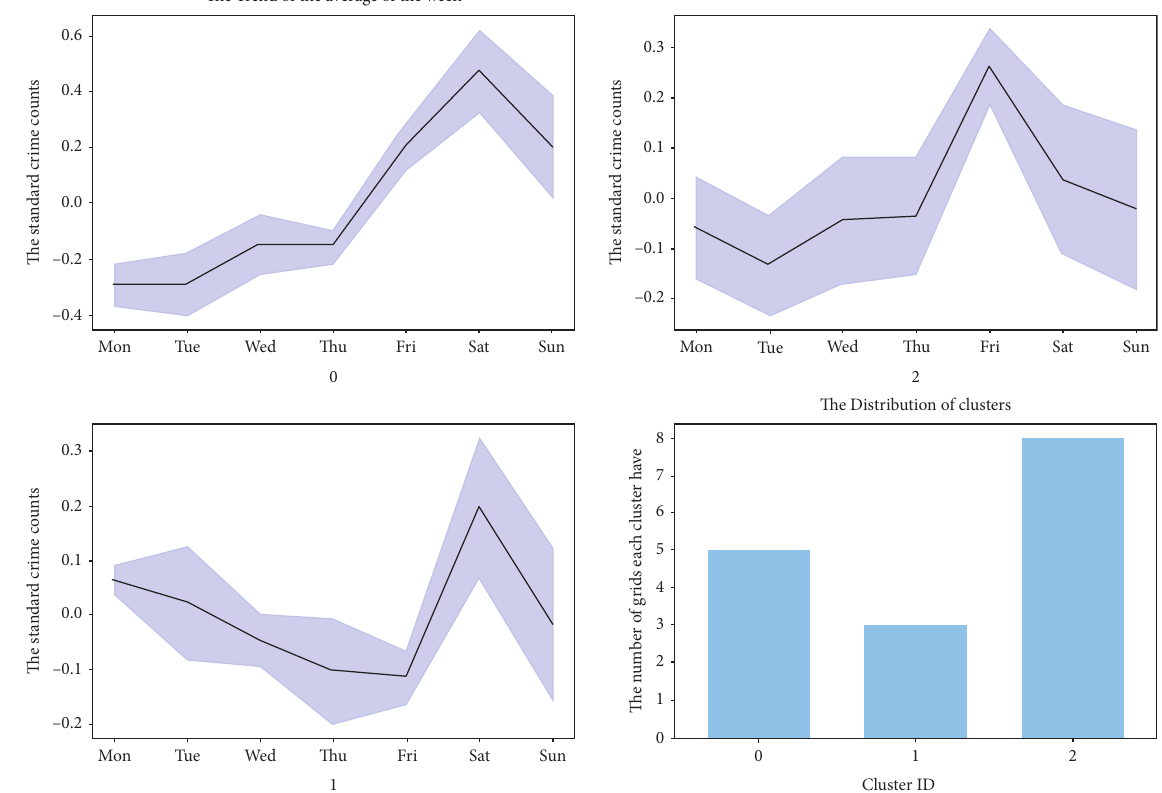
Figure 9: The theft in San Francisco trends in the average weeks in 2018 and the distribution of clusters. The line charts are the weekly trends of theft in San Francisco in 2018. The bar chart is the distribution of the clusters.